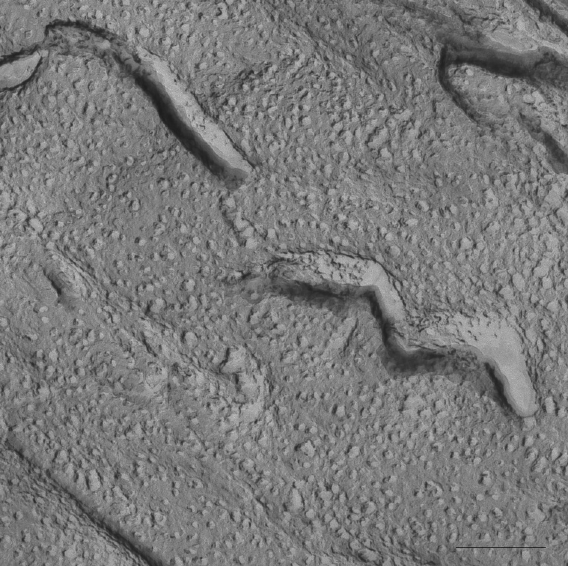
Figure 4. Electron micrograph image of the S-q2 system at 40 °C showing isolated elongated aggregates. Bar = 1.00 µm.